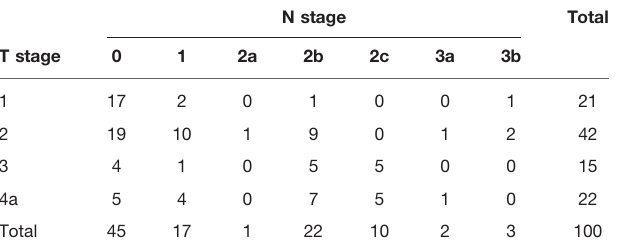
Table 2 | Distribution of clinical T and N classi fi cation of patients with hypopharyngeal cancer. N stage Total